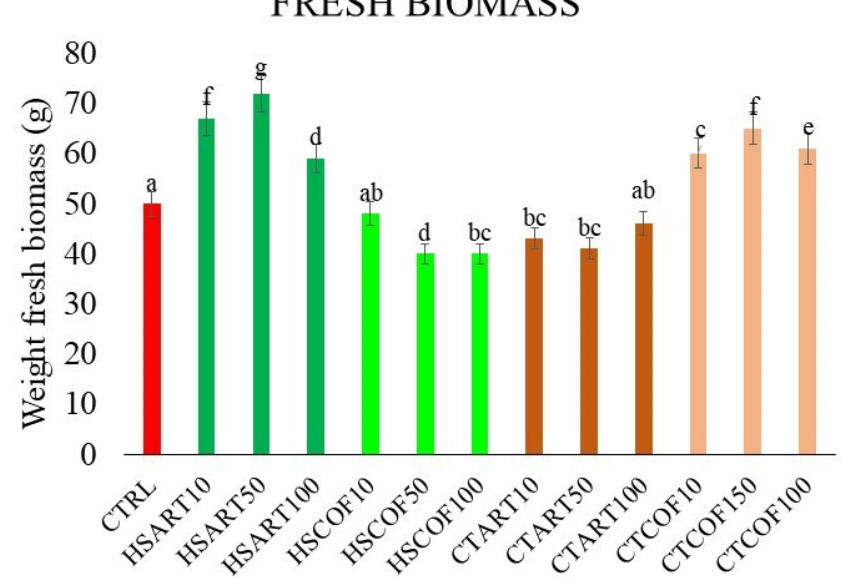
Figure 2. Effect of HS and CTs on weight fresh biomass of Ocimum basilicum plants. The different colors are associated to organic treatments applied (CTRL-red; HS-ART-green; HS-COF light green; CT-ART-brown; CT-COF orange). Vertical bars represent the standard deviation of the mean. Columns (mean ± S.D.) followed by different letters indicate significant difference according to LSD test ( p ≤